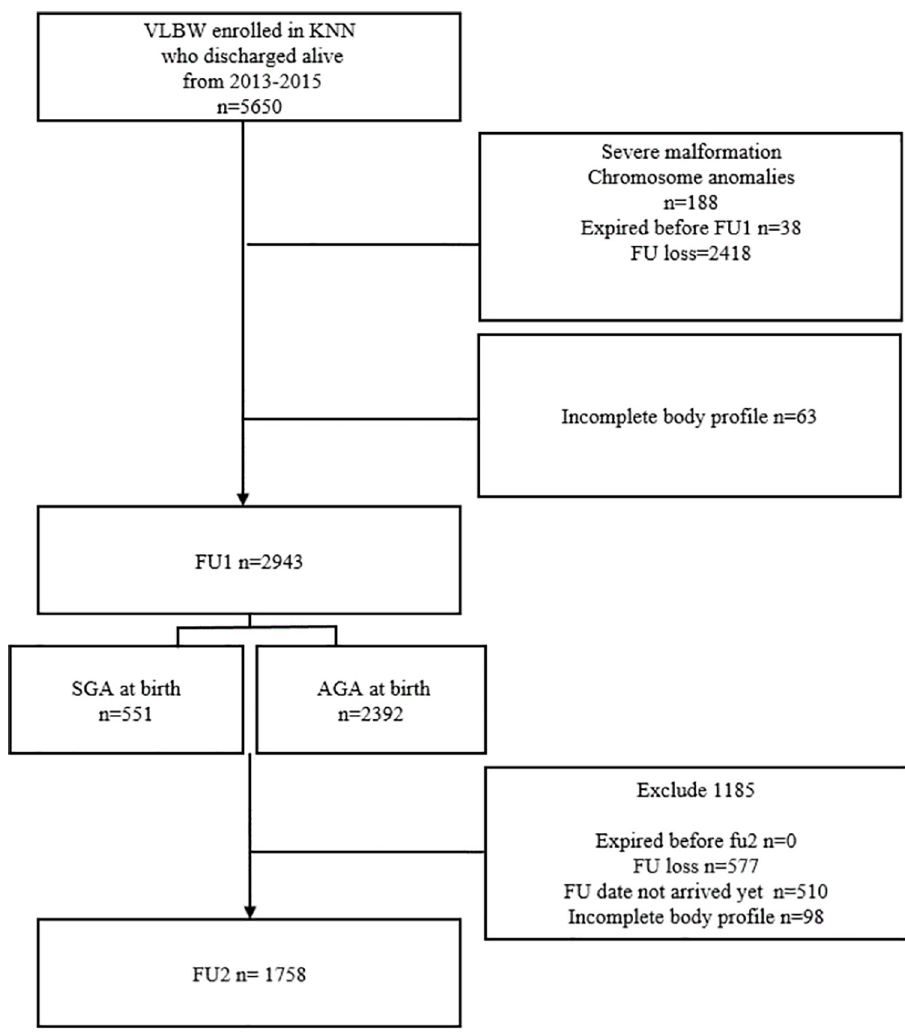
Fig 1. Flow chart of study population. information without body weights, and 2418 infants who were lost to follow-up were excluded (Fig 1). Demographic data, including the gestational age, birth weight, sex, maternal factors, comorbidities, and outcomes after discharge, were obtained from the database. Weight was measured following a standardized manual of operation from the KNN. Infant’s weight right after birth and at the time of discharge was measured on an electronic scale on a flat and hard surface. At FU1 and FU2, the infant stood on the scale in a neutral, still position with only a diaper or underwear. If they could not stand up, they were put on the scale in a supine posi- tion. the scale was zeroed before every measurement. Growth curves included the Fenton growth chart until a post-menstrual age of 50 weeks and the World Health Organization (WHO) growth charts at FU1 and FU2. Corrected age at FU1 and chronological age at FU2 was entered to an online WHO calculator to convert body weight to z-score (https:// worldhealthorg.shinyapps.io/anthro/). Small for gestational age (SGA) was defined as a birth weight z-score below -1.28 (10th percentile) for gestational age using Fenton growth charts.